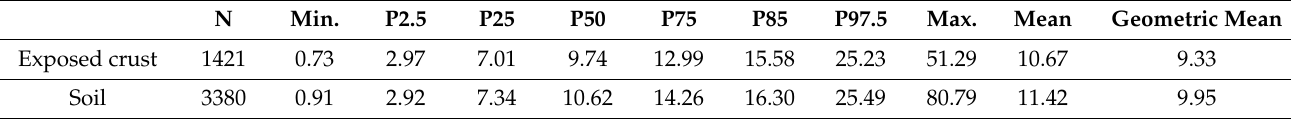
Table 2. Statistical parameters of cobalt abundance of exposed crust and deep soils throughout China (mg/kg). N = Number of samples; P = Percentile (P50 = median); Min. = Minimum; Max. = Maximum. The soil data were quoted from Liu et al.